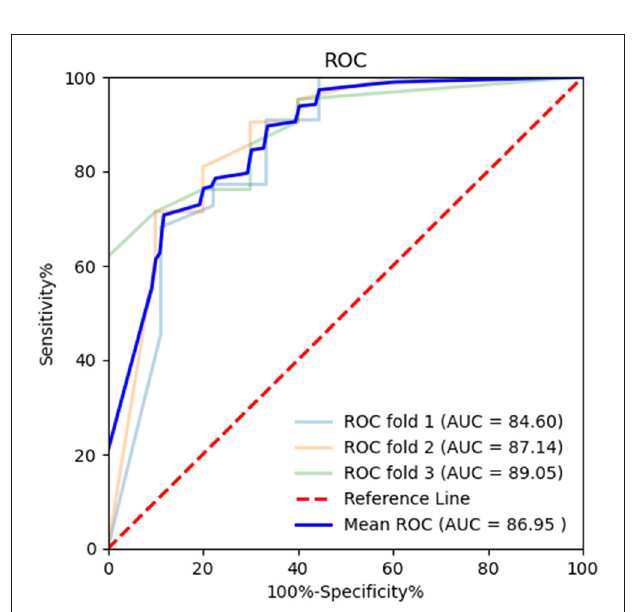
FIGURE 5 | Receiver operating characteristic (ROC) curve of BR alternation rate in k-fold cross-validation. K-fold cross-validation was used to evaluate the predictive performance of BR alternation rate and MoCA. The average area under the curve (AUC) was 0.870, sensitivity 89.36%, and specificity 62.25%.